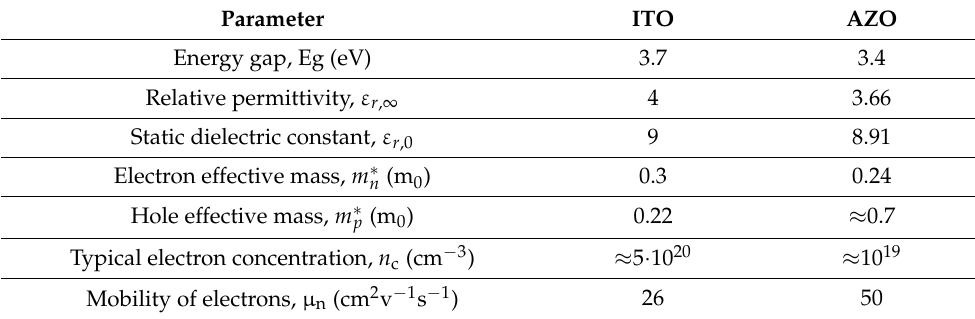
Table 1. Basic parameters of indium-tin oxide (ITO) and Al-doped ZnO (AZO) thin films. Parameter